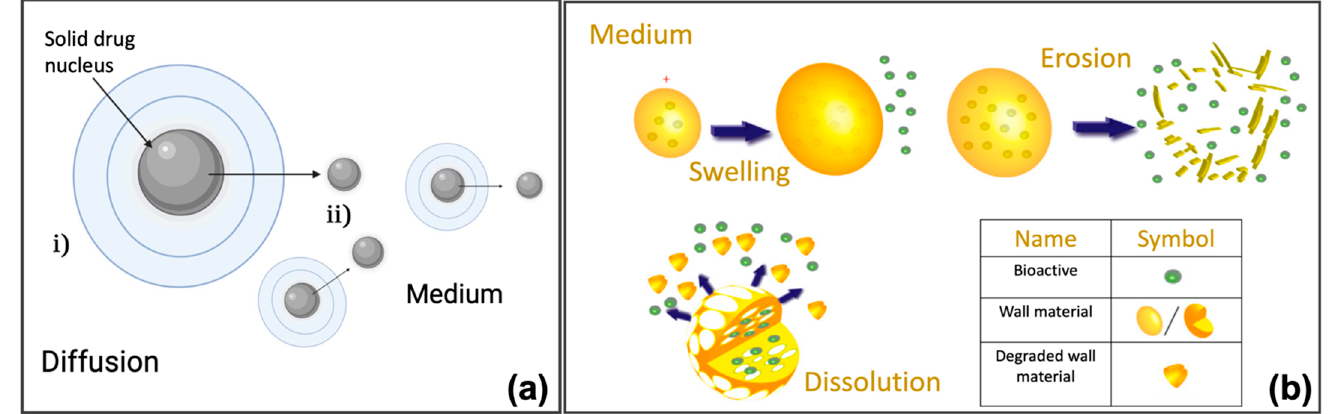
Figure 9. ( a ) Schematic representation of the drug diffusion processes from micro or nanoparticles. The figure shows a typical structure of micro/nanoparticles, with a solid drug nucleus: as the dissolution process proceeds, the solid drug diffuses from (i) the micro/nanoparticles to (ii) the medium. Created with BioRender.com (accessed 6 February 2022). ( b ) Representations of swelling, erosion, and dissolution. Reprinted from [159].